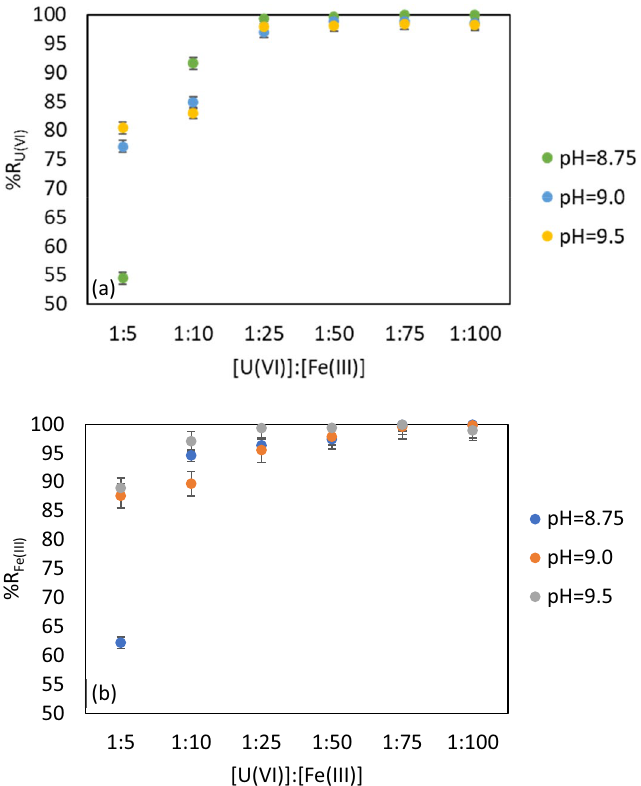
Figure 4. ( a ) %R U(VI) = f ([U(VI)] : [Fe(III)]) in the optimal pH range; ( b ) %R Fe(III) = f([U(VI)] : [Fe(III)]) in the optimal pH range (V V sample : V water =